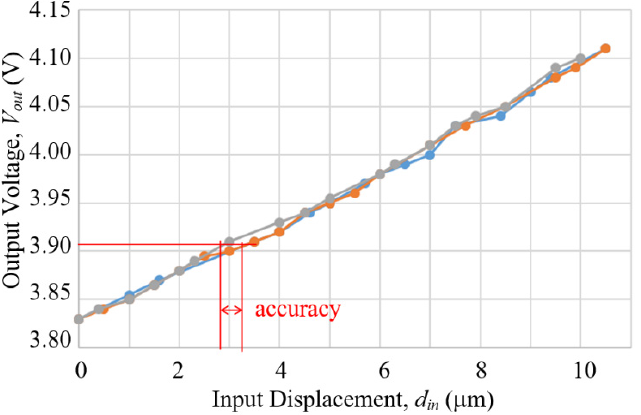
Figure 21. Results of three separate measurements of the proof-of-concept prototype by using a Hall sensor and a tape magent to measure output displacement, increasing input displacement meaning decreasing the gap distance between the Hall sensor and the tape magnet at position B on the third arm.